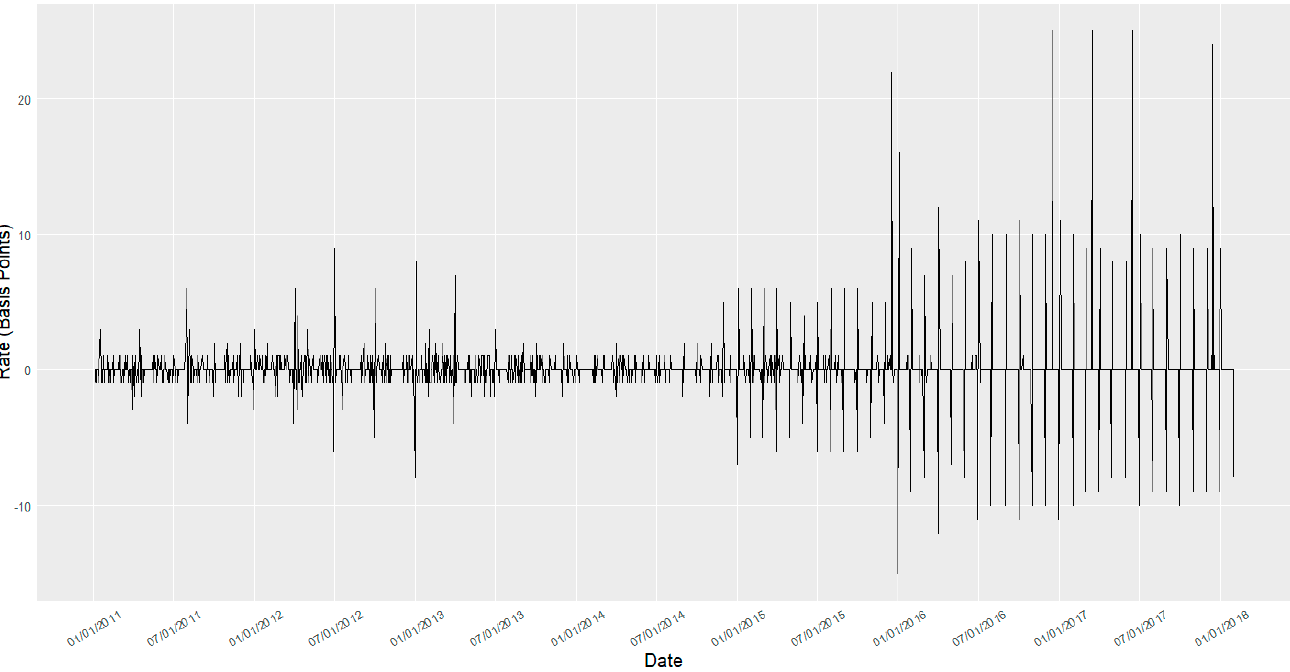
Figure 5. Time Series Plots of ∆ Effective Federal Funds Rate.